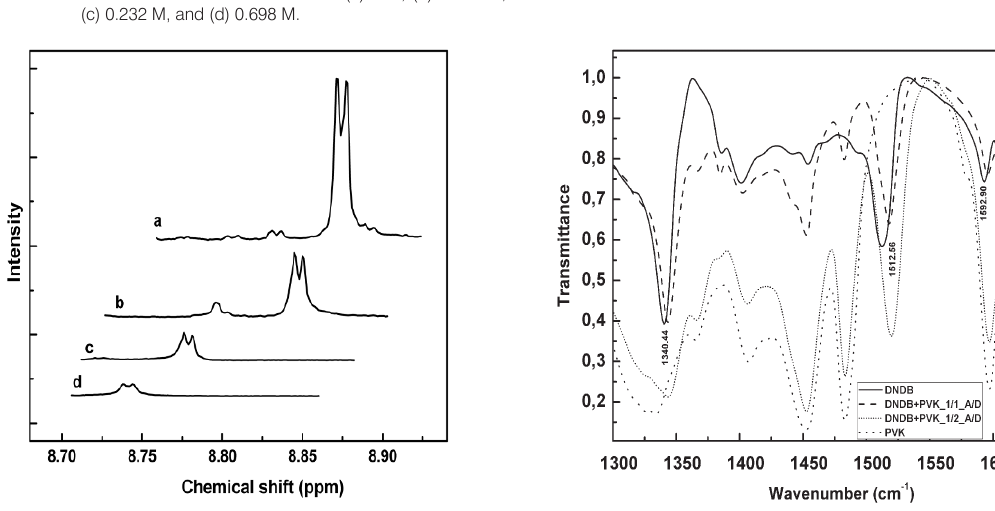
Figure 7. Expanded 1 H-NMR spectra for TNDB in mixtures with different PVK concentrations: (a) 0 M, (b) 0.061 M, (c) 0.313 M and (d) 0.565 M.